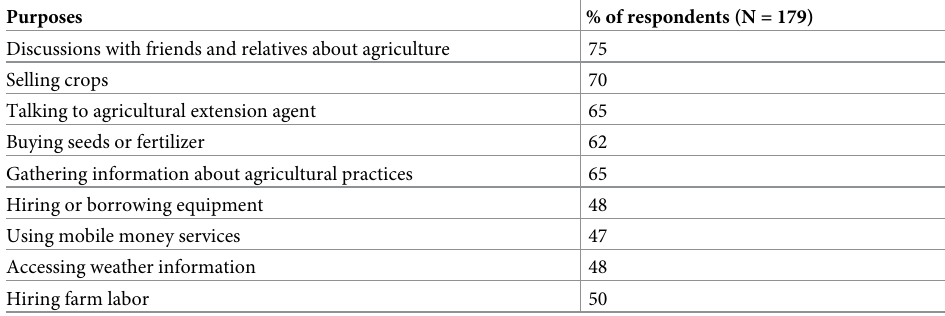
Table 3. Percentages of respondents using their own mobile phones for specific agricultural purposes.